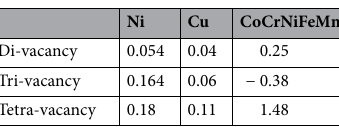
Table 5. Average binding energies (eV) of vacancy clusters Vn (n = 2, 3, 4) in Ni, Cu, and CoCrNiFeMn